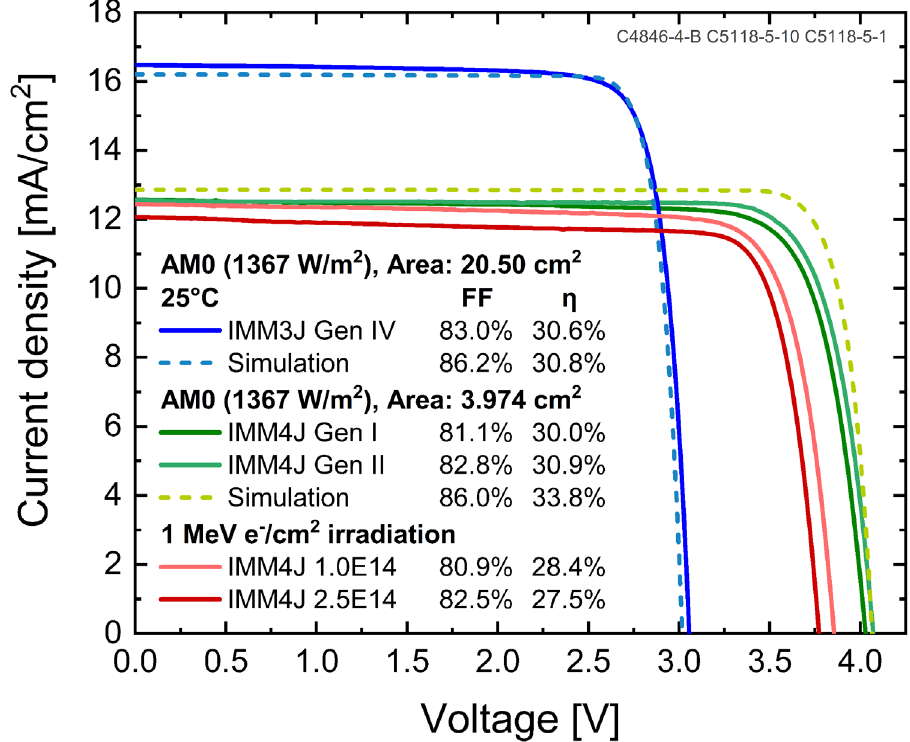
Fig. 4. Light IV curves for the fi rst two generations of IMM4J solar cells in BOL condition (solid green). The light IV curve for the last generation of IMM3J in BOL condition is shown for comparison (solid blue). The simulated realistic potential IV curves for both devices are shown as dashed lines. IV curves of the best cells after 1 MeV electron irradiation with a fl uence of 1 (cid:1) 10 14 e – /cm 2 and 2.5 (cid:1) 10 14 e – /cm 2 are shown in solid pink and red